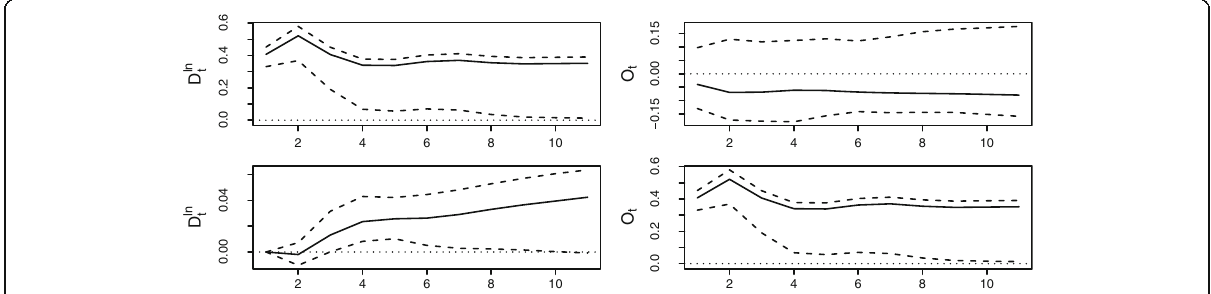
Fig. 4 Orthogonal impulse response functions with 95% bootstrap CI for boom phases. Top: from D ln